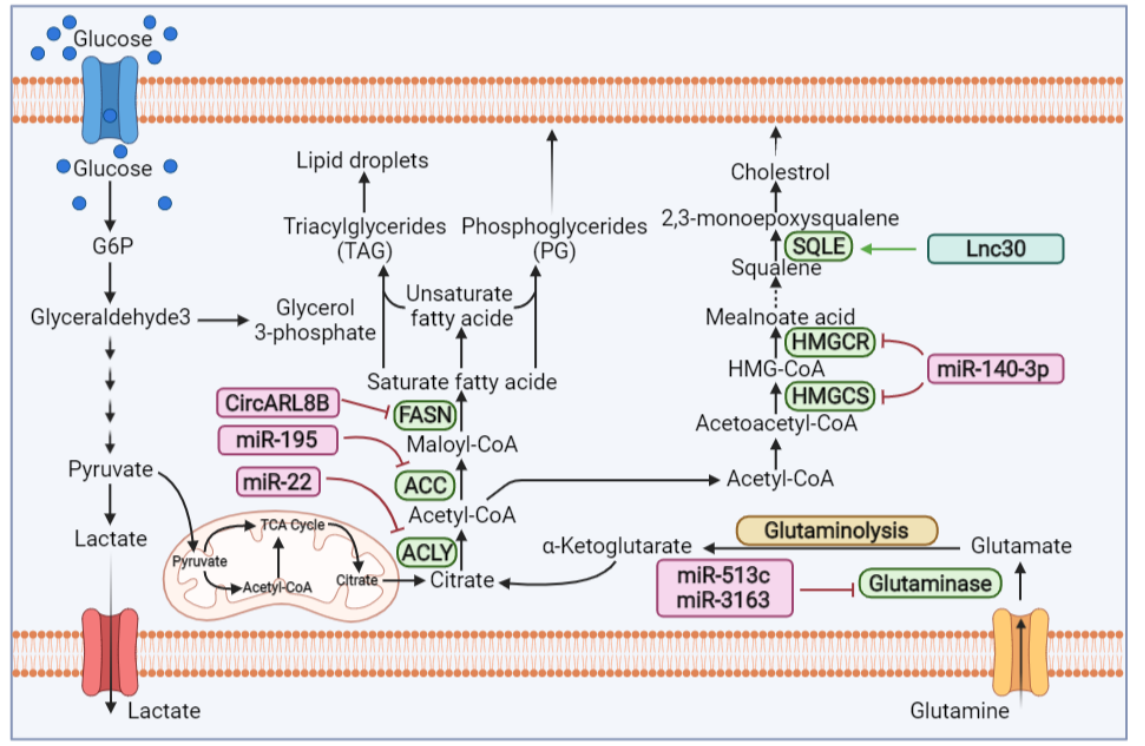
Figure 2. Representation of the steps in the lipogenesis cycle, cholesterol and glutamine regulated by ncRNAs in reprogramed BC. ncRNAs can modulate the molecules of lipids and cholesterol by regulating of the expression ACLY, ACC, HMGCS, HMGCR and SQLE enzymes. Moreover, ncRNAs induced their regulatory role on the conversation of glutamine to glutamate pathway via downregulation of glutaminases enzyme. The enzymes that are downregulated by ncRNAs are shown by the red arrow, whereas the upregulation effect of ncRNAs is illustrated by the green ar- row. ACLY, ATP citrate lyase; ACC, Acetyl-CoA carboxylase; FASN, Fatty Acid Synthase; HMGCS, hydroxymethylglutaryl-CoA synthase; HMGCR, 3-Hydroxy-3-Methylglutaryl-CoA Reductase; SQLE, Squalene